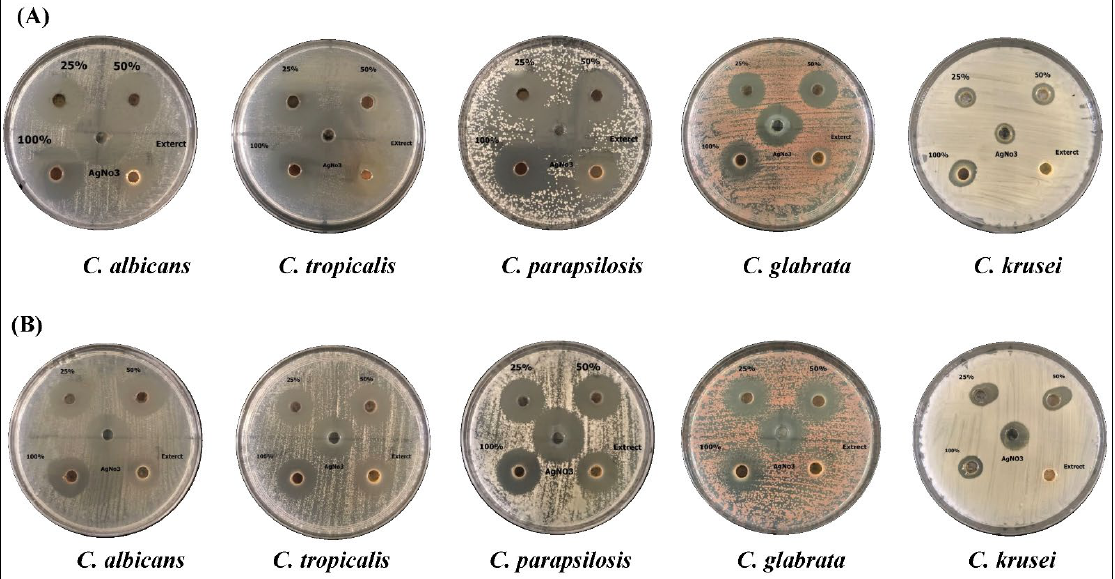
Figure 4. The antifungal activity of AgNPs preparations from Phoenix dactylifera L leaf extracts. Candida spp. were grown on Sabaroud Dextrose Agar Plates and treated with three concentrations of AgNPs (25, 50, 100% (10 mg/mL), AgNO 3 (2 mM), and crude extracts (10 mg/mL). ( A ) aqueous extract, ( B ) ethanolic Table 2. Zone of inhibition for Candida spp. treated with AgNPs of the Palm leaves aqueous extract. Species